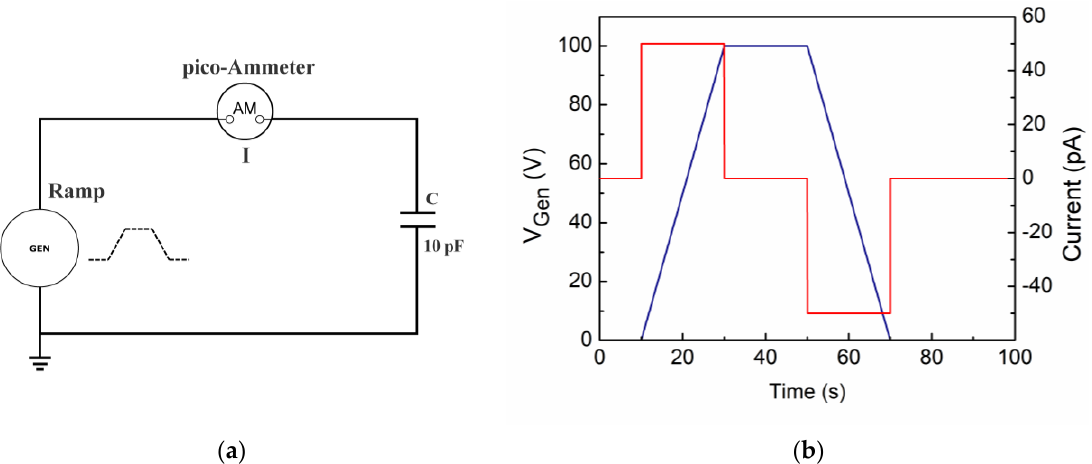
Figure 2. A 5 V/s voltage ramp is applied to a commercial capacitance C = 10 pF: ( a ) electrical circuit schematic; ( b ) the applied voltage stimulus (blue line—left scale) is shown. The output current (red line—right scale) shows the expected behavior for an ideal capacitor (see text).